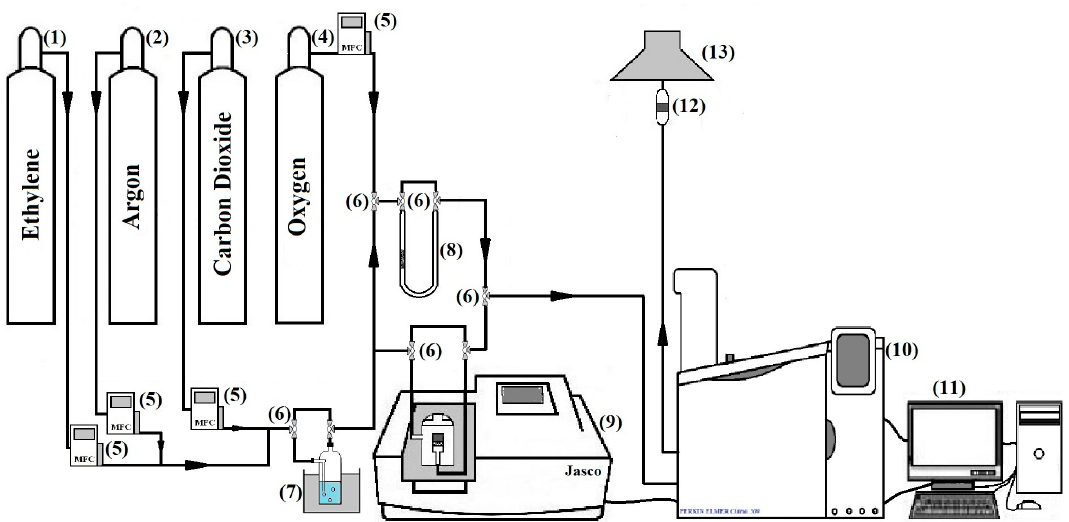
Figure 1. General experimental setup used to study surface interactions among ethylene and zeolite by diffuse reflectance infrared Fourier transform spectroscopy (DRIFTS) in operando mode and the retention of ethylene and carbon dioxide using a quartz U-shaped fixed bed adsorber at room temperature: (1) ethylene cylinder, (2) argon cylinder, (3) carbon dioxide cylinder, (4) oxygen cylinder, (5) mass flow controller, (6) three way valve, (7) water saturator, (8) U-type fixed bed adsorber, (9) Praying Mantis diffuse reflectance cell set in a JASCO Fourier transform infrared spectroscopy (FT/IR 4700) spectrometer, (10) Perkin Elmer Clarus 500 gas chromatograph, (11) computer, (12) KMnO 2 trap, and (13) extractor hood.